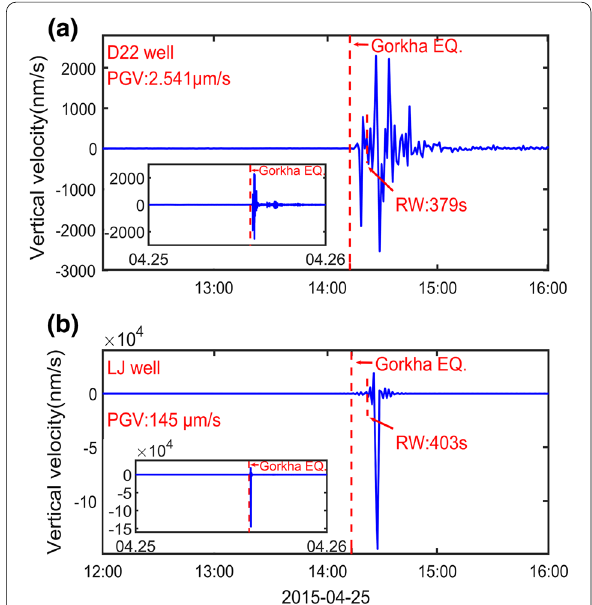
Fig. 3 Vertical velocity seismic wave records at the D22 ( a ) and LJ ( b ), The unit is nm/s. The red dotted lines represent the earthquake origin time. PGV represents the ground peak velocity of seismic wave. RW is the arrival time of Rayleigh wave